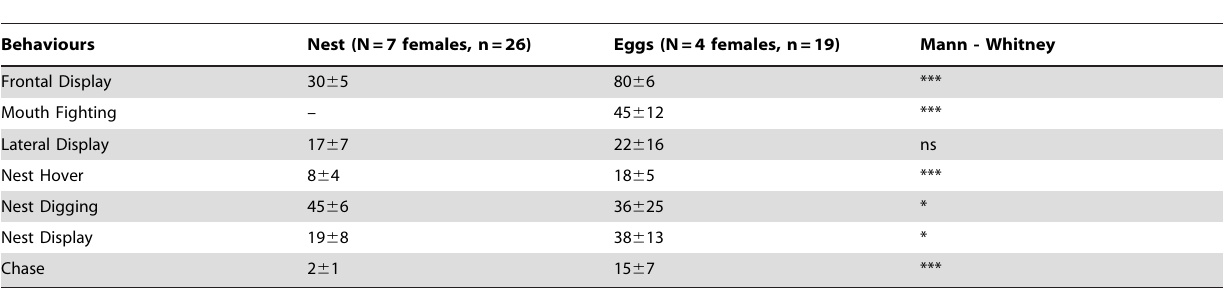
Table 9. Mean percentage ( 6 SE) of co-occurrence between a behaviour and a production of sounds.